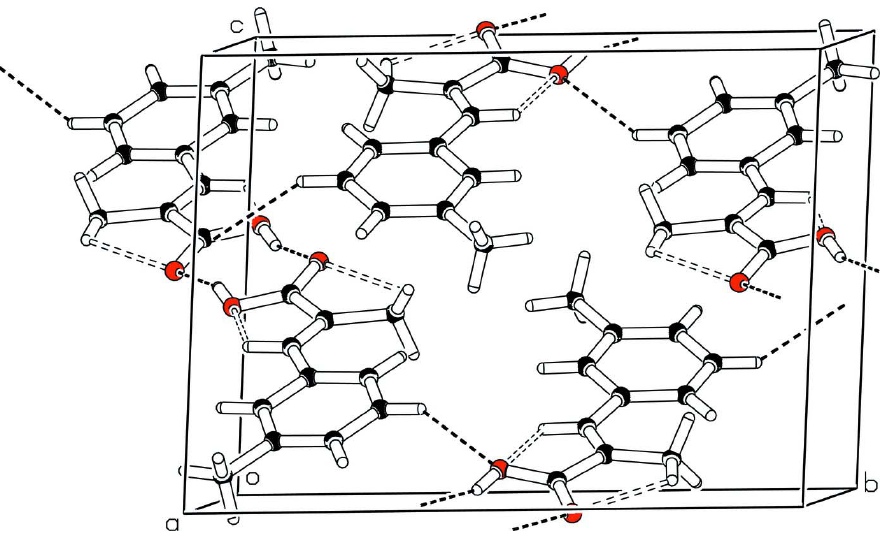
The packing figure ( PLATON : Spek, 2003) which shows the dimeric nature of the compound and the interlinkages of the